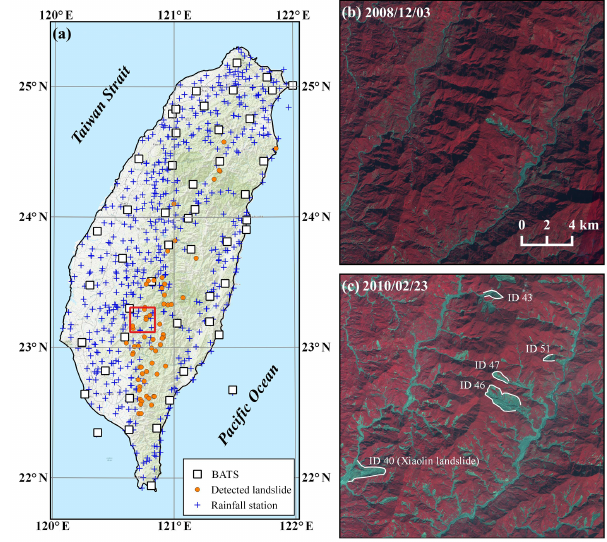
Figure 2. Comparison of satellite images pre- and post-Typhoon Morakot. (a) Overview map of Taiwan and distribution of rainfall gauge stations. The red frame denotes the areas displayed in (b) and (c) . (b) SPOT image taken on 3 December 2008. (c) SPOT im- age taken on 23 February